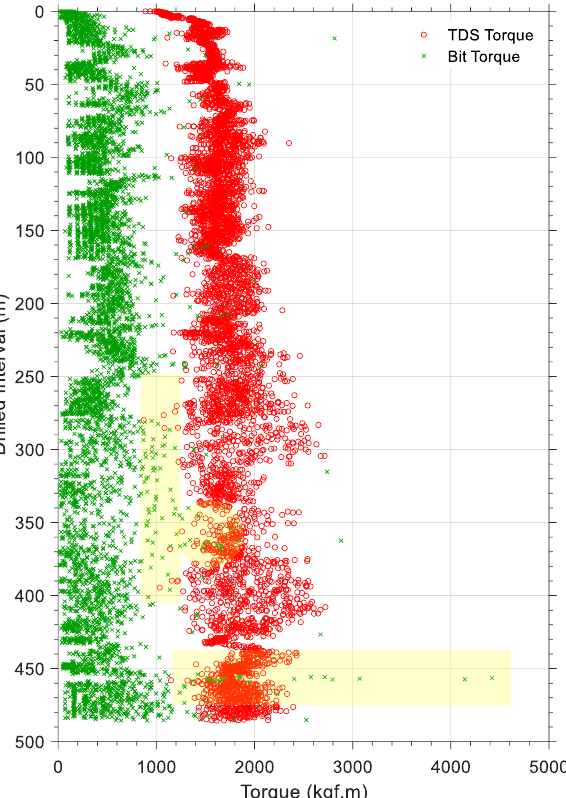
Figure 21. Torque at bit and torque delivered to the drill string at the surface for bit run number